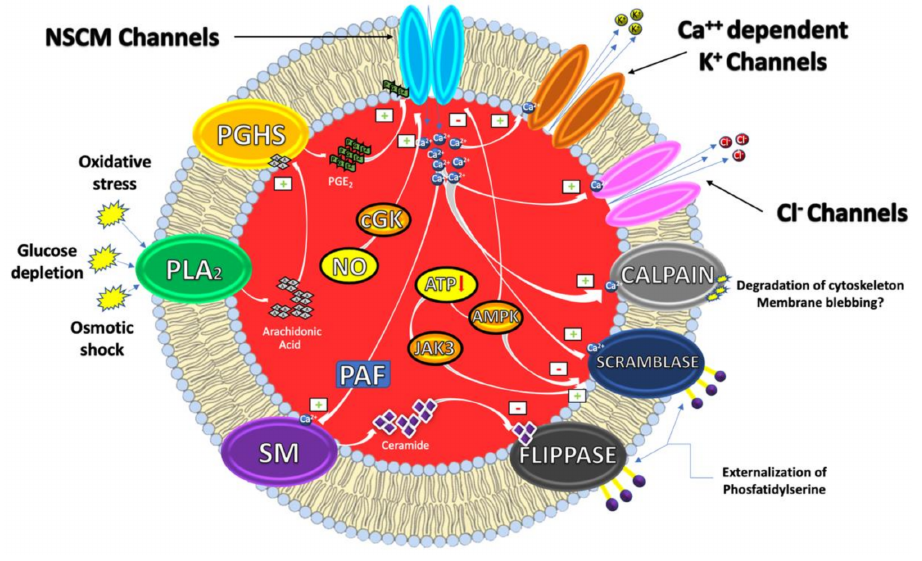
Figure 1. Eryptosis